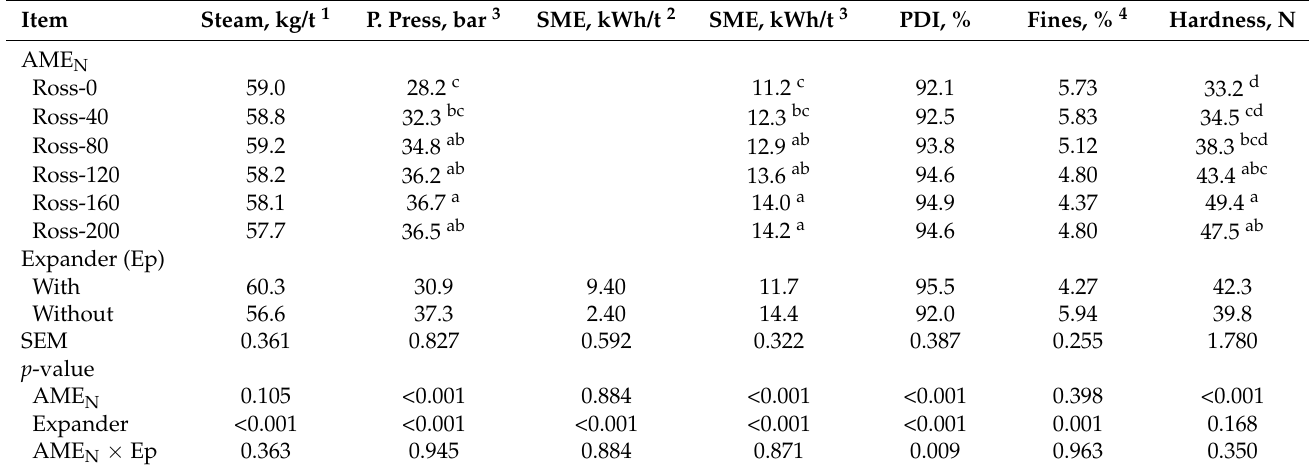
Table 4. Feed processing applied to diets and the pellet quality of